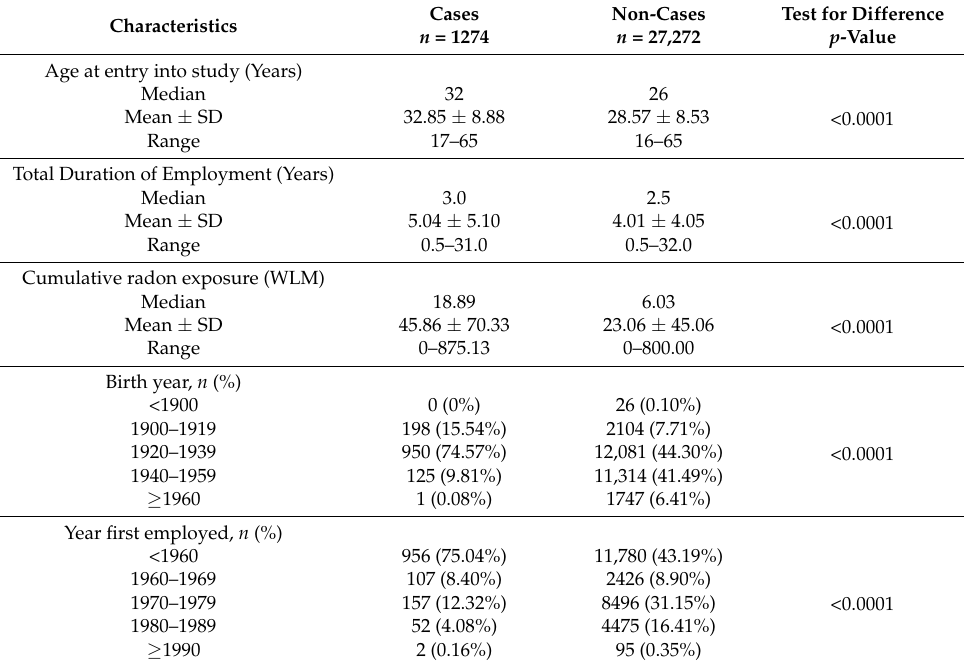
Table 2. Characteristics of the Ontario Uranium Miners